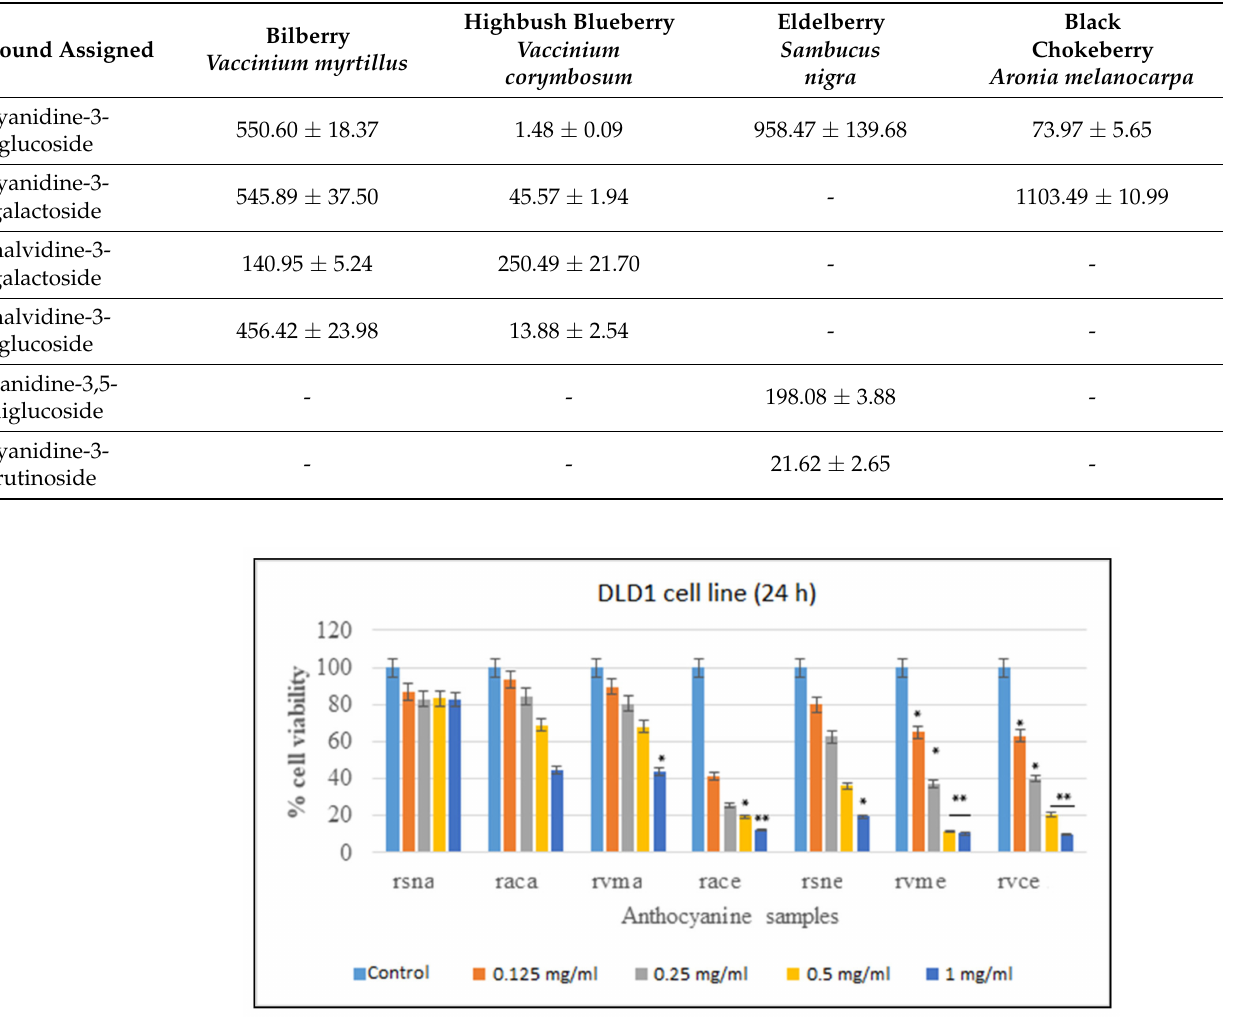
Figure 1. The antiproliferative effects of anthocyanines for 24 h application (* p < 0.05; ** p < 0.001).